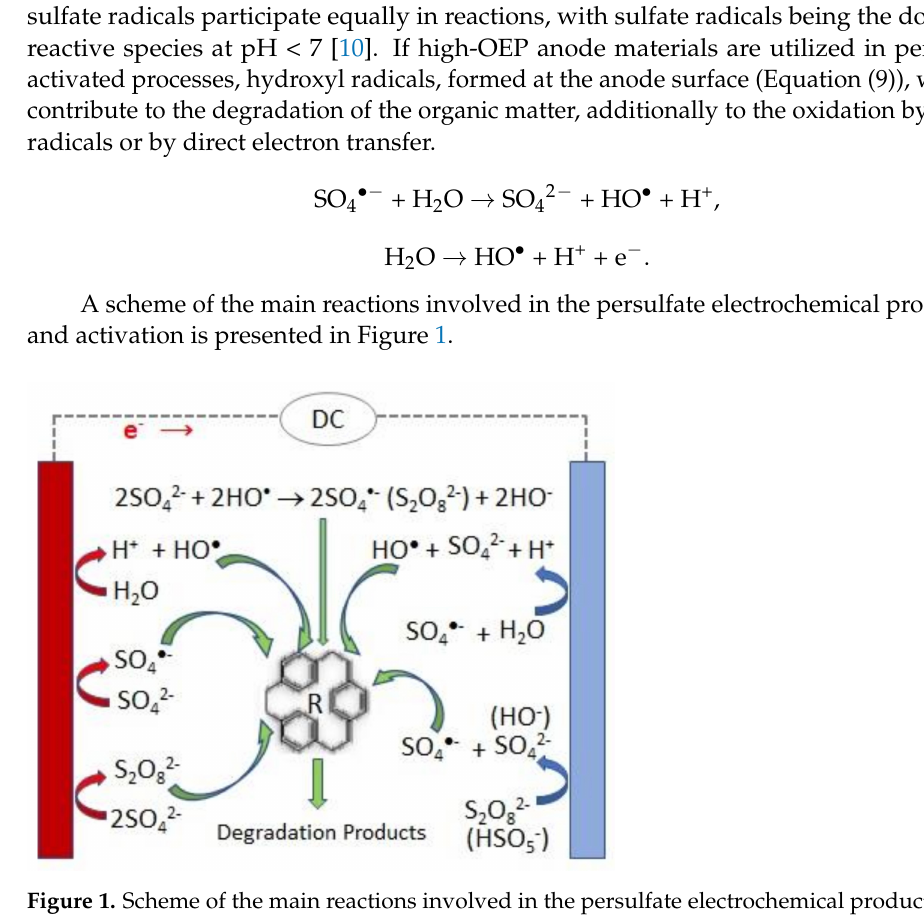
Figure 1. Scheme of the main reactions involved in the persulfate electrochemical production and